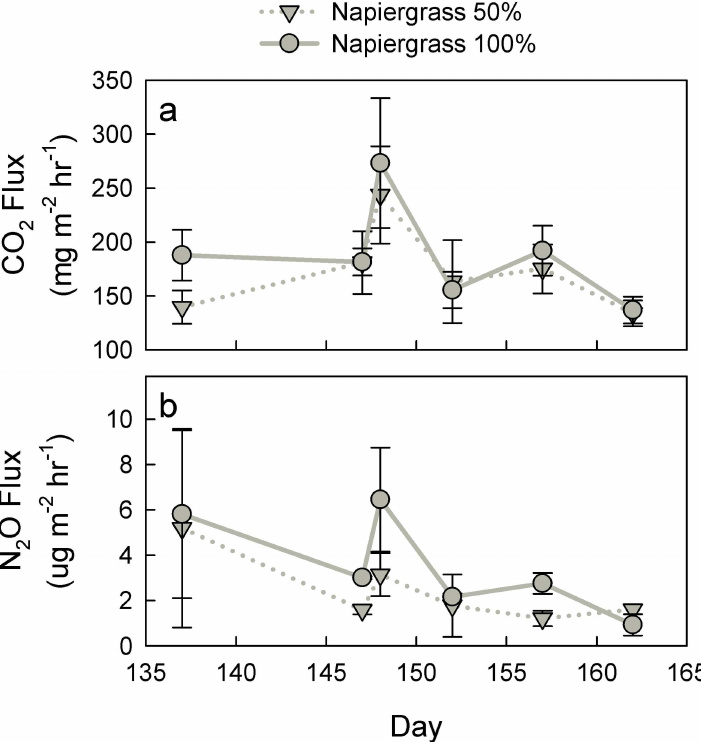
Fig 2. Gas fluxes peak following harvest. CO 2 (a) and N 2 O (b) flux followingharvest; values are means ( ± one standard